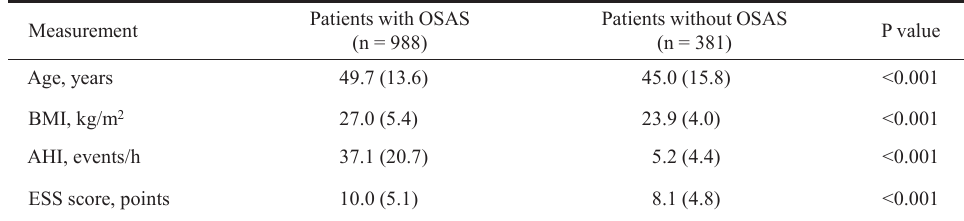
Table 1. Patient characteristics